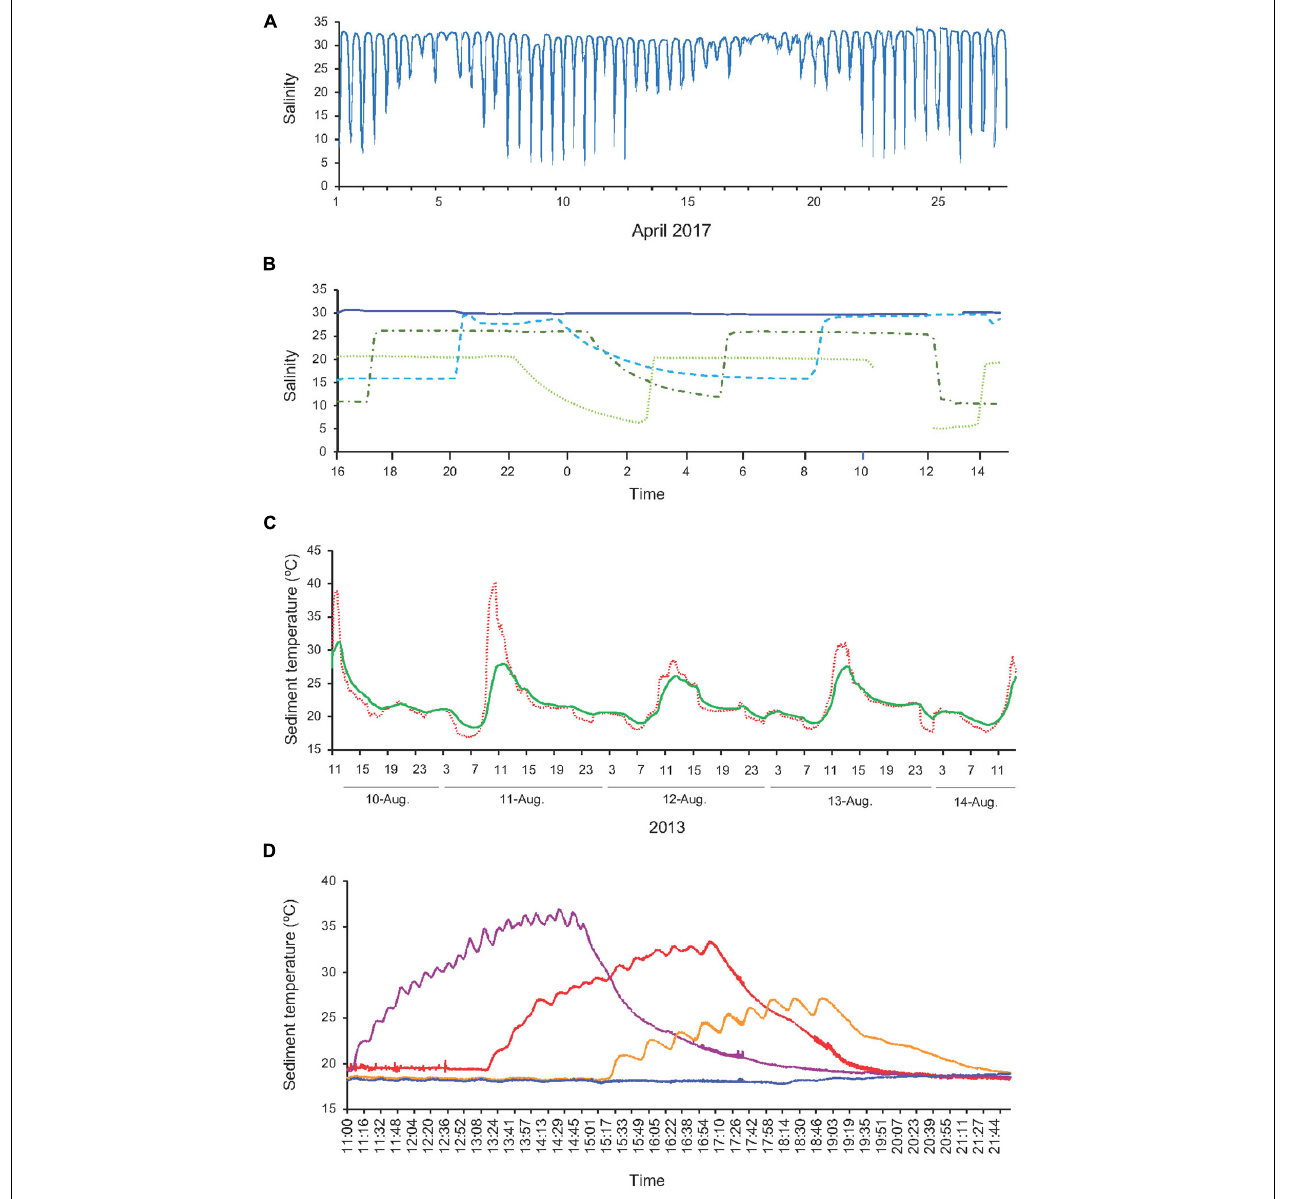
FIGURE 3 | Salinity and temperature profiles. (A) Salinity at Cambados shellfish bed in April 2017 (data from mini-CTDs). (B) Salinity for each treatment during March 2016 experiments. Solid dark blue line corresponds to S30, dashed light blue line to S15, dash and dotted dark green line to S10 and dotted light green line to S5. Missing values correspond to emersion (data from mini-CTDs). (C) Temperature at surface of the sediment (dotted solid line) and at 2 cm depth within the sediment (green solid line) at Redondela shellfish bed from the 10th to 14th of August 2013 (data from i-buttons). (D) Temperature for each treatment during July 2016 experiment at 2 cm depth within the sediment (data from i-buttons); blue line corresponds to T20, yellow line to T27, red line to T32 and purple line to